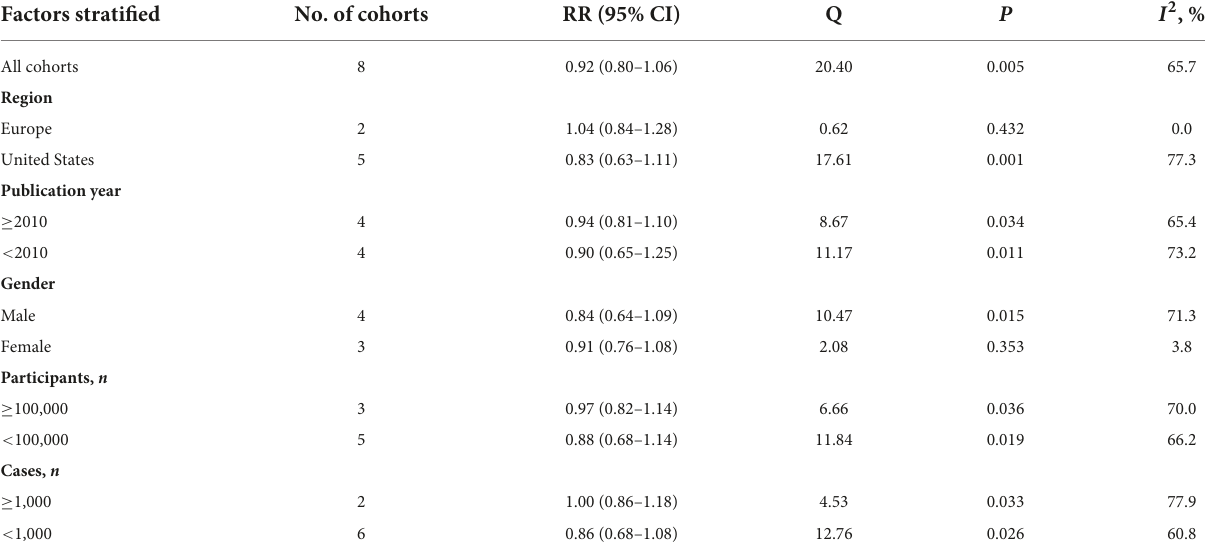
TABLE 2 Subgroup analyses for the relationship between consumption of cruciferous vegetables and the risk of bladder